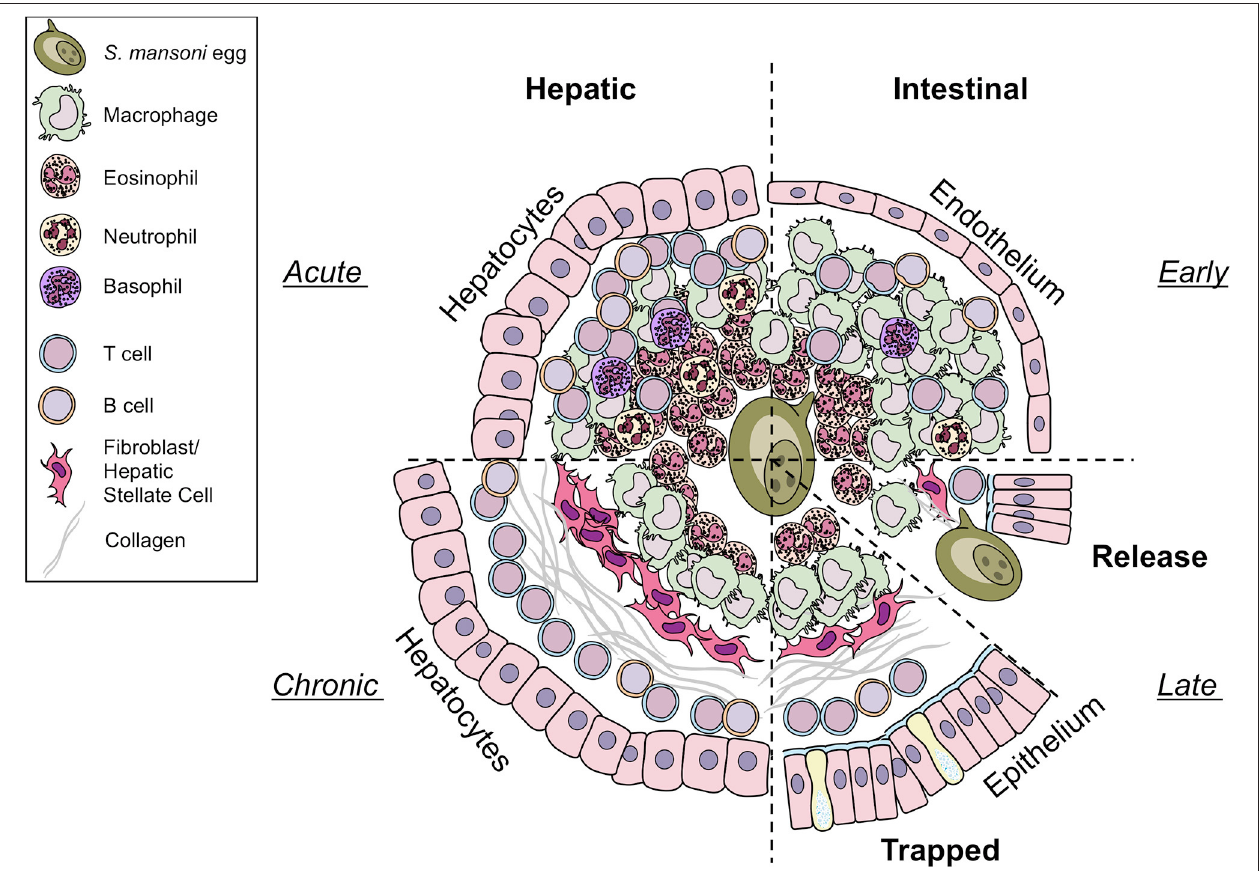
FIGURE 1 | Differences in hepatic and intestinal granuloma composition. Cellular granuloma composition in the liver (left) and the intestine (right). While early (upper half) granulomas may appear similar, intestinal granulomas harbor less eosinophils, T cells, and B cells than hepatic granulomas, more macrophages are present. Only few neutrophils and basophils can be observed in both sites. During later stages (lower half) eggs in the liver become trapped and fibrosis develops. In contrast, eggs deposited in the gut must be released to the intestinal lumen by yet to define mechanisms. However, they may also become trapped and may resemble chronic liver granulomas in shape and collagen content. Illustrations modified from Servier Medical Art, licensed under a Creative Common Attribution 3.0 Unported